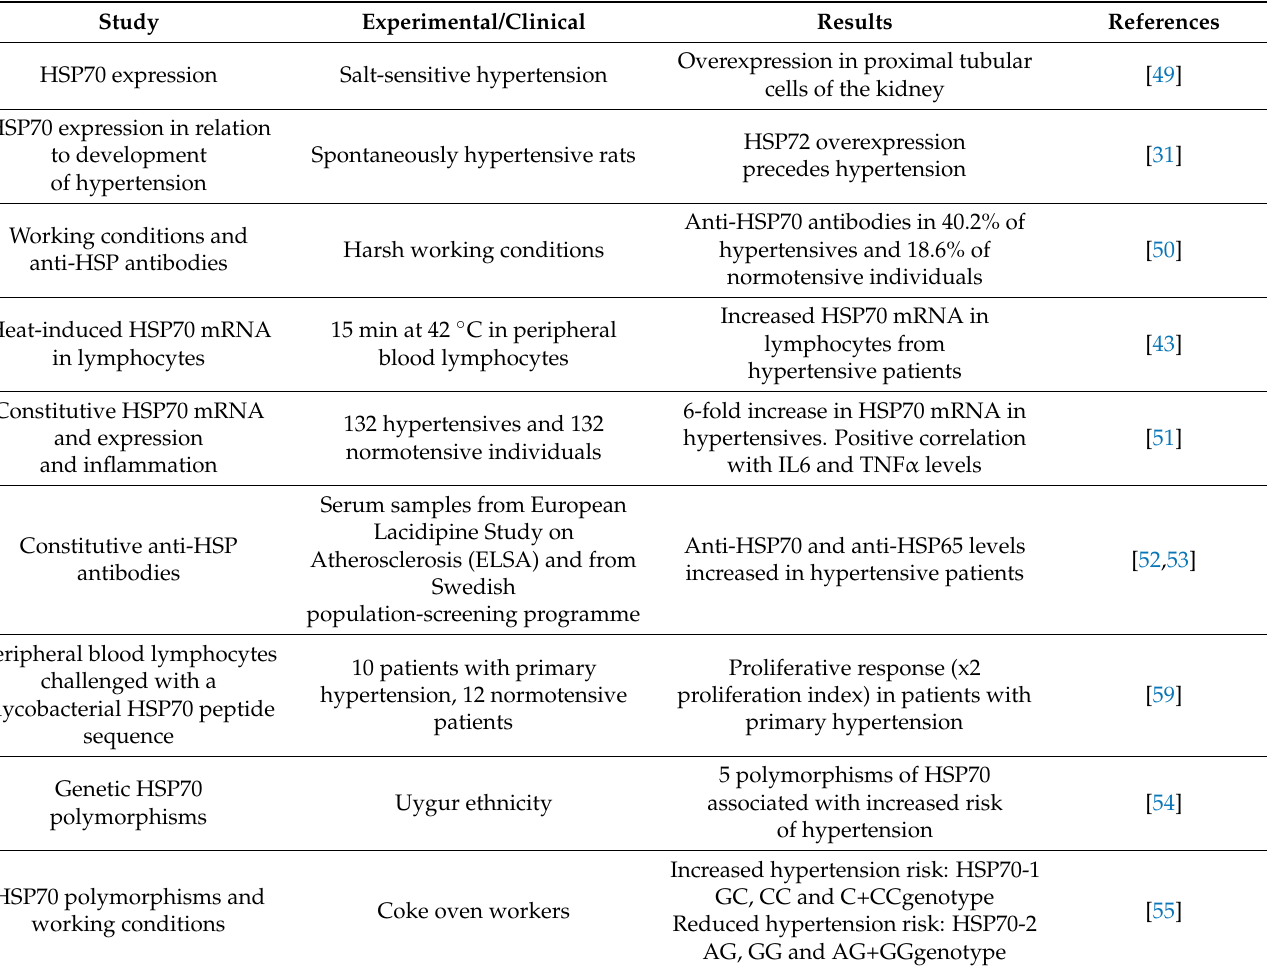
Table 1. Association between HSP70 and